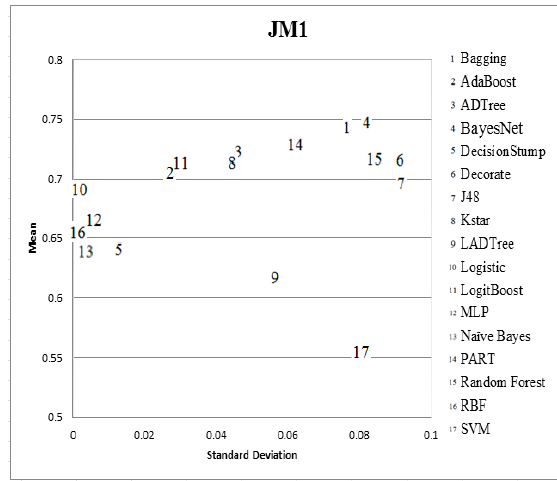
Figure 9. AUC mean value with 4 scenarios and deviation from mean in JM1 dataset classification.